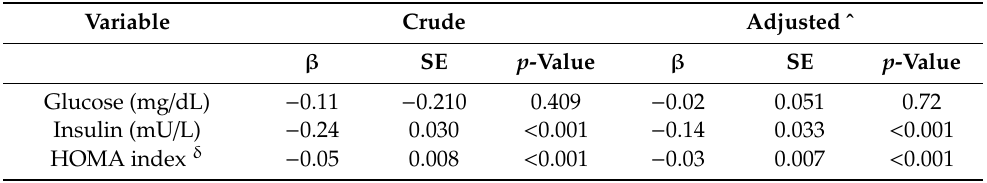
Table 3. Multivariate linear regression analysis to assess relationship between vitamin D concentrations and HOMA index, glucose, and insulin in Mexican children and adolescents. Variable Crude Adjusted ˆ β SE p -Value β SE p -Value Glucose (mg / dL) − 0.11 − 0.210 0.409 − 0.02 0.051 0.72 − 0.24 0.030